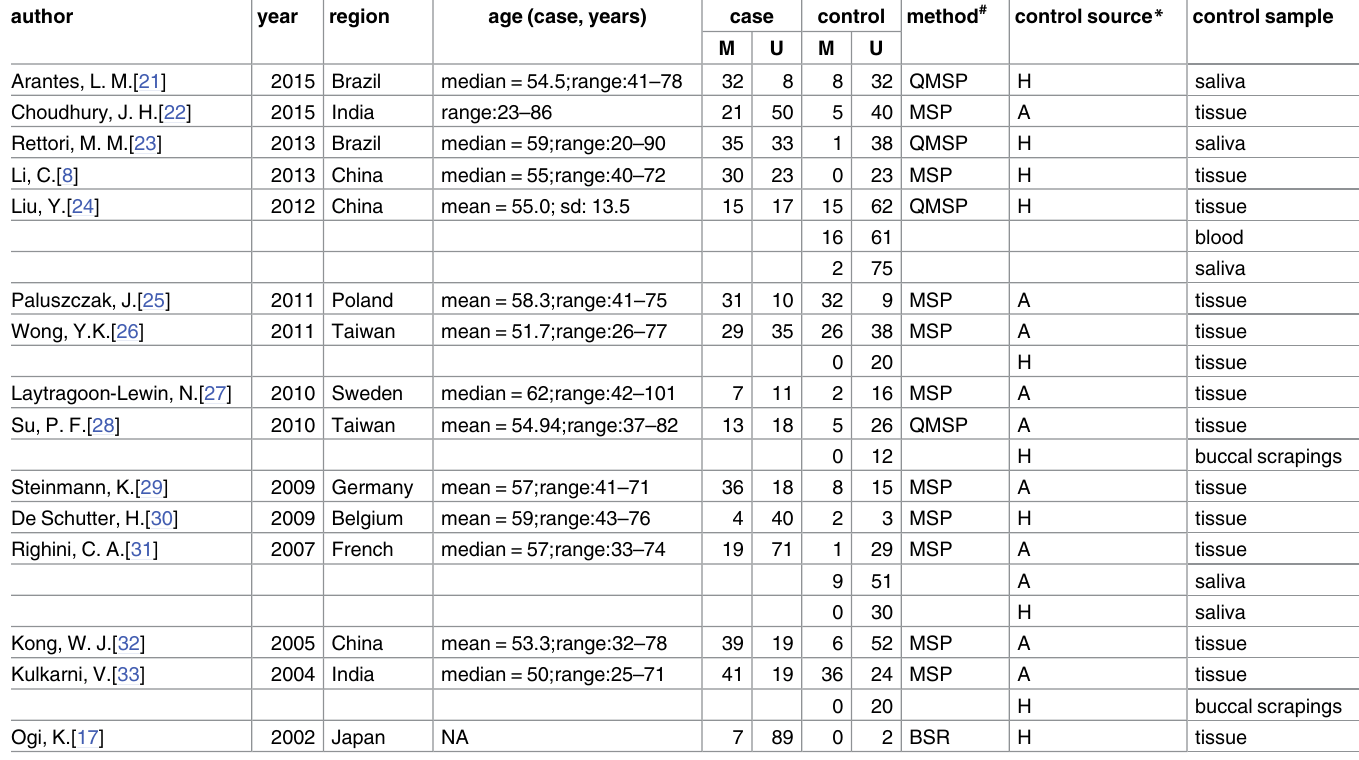
Table 1. Characteristics of studies included in the meta-analysis of DAPK promoter methylation and HNSCC.